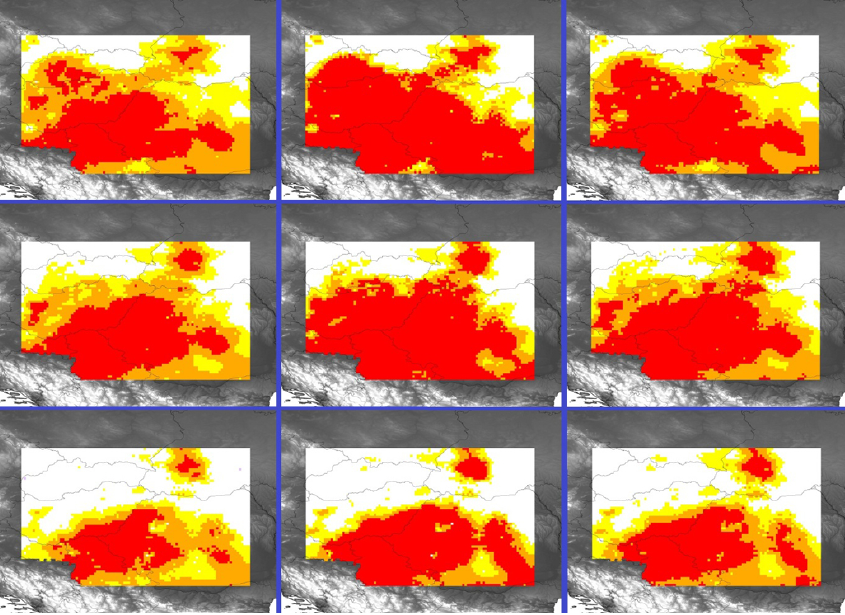
Figure 4. Spatio-temporal evolution of drought from October 2000 (top images), to November 2000 (center) and December 2000 (bottom). From left column to right, SPI-6, SPEI-6, and RDI-6. See Table 2 for